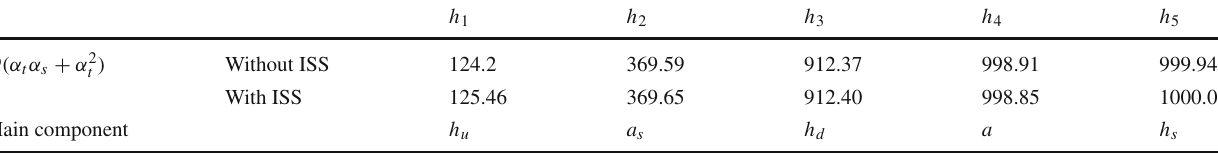
Table 1 Parameter point P1 : Mass values in GeV and main components of the neutral Higgs bosons at two-loop O (α t α s + α 2 t ) obtained for the NMSSM without and with the inverse seesaw mechanism using OS renormalization in the top/stop sector h 1